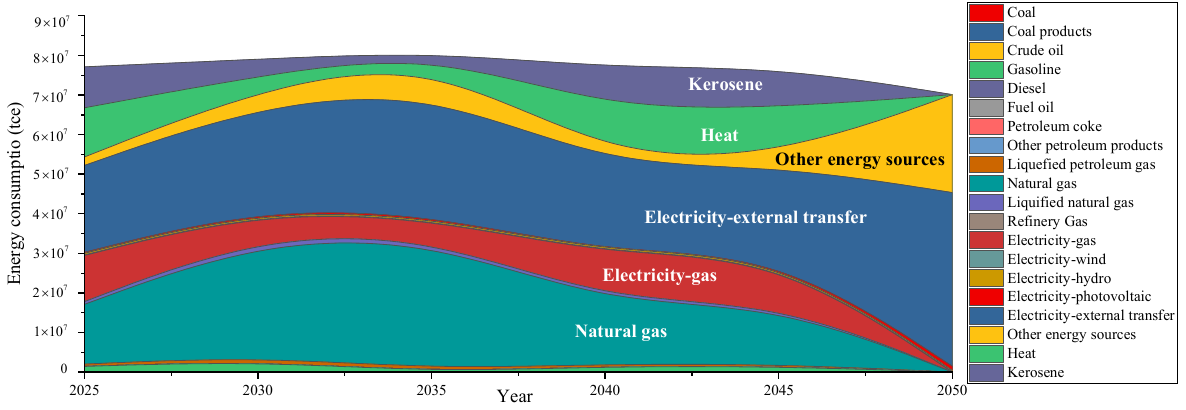
Figure 6. Summary of consumption of various energy types under the ELC scenario.